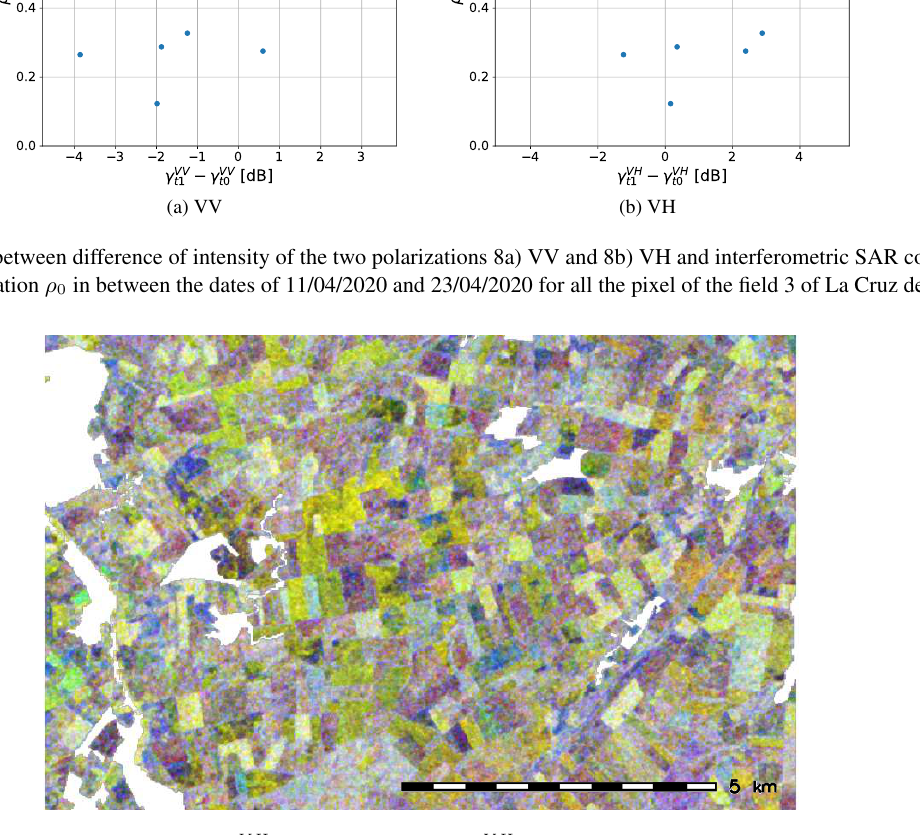
Figure 9. False color image composed by γ V H 0 in 11/04/2020 in red, γ V H 0 in 23/04/2020 in green and VH coherence ρ between 11/04/2020 and 23/04/2020 in blue. Sensing of Environment , 268,